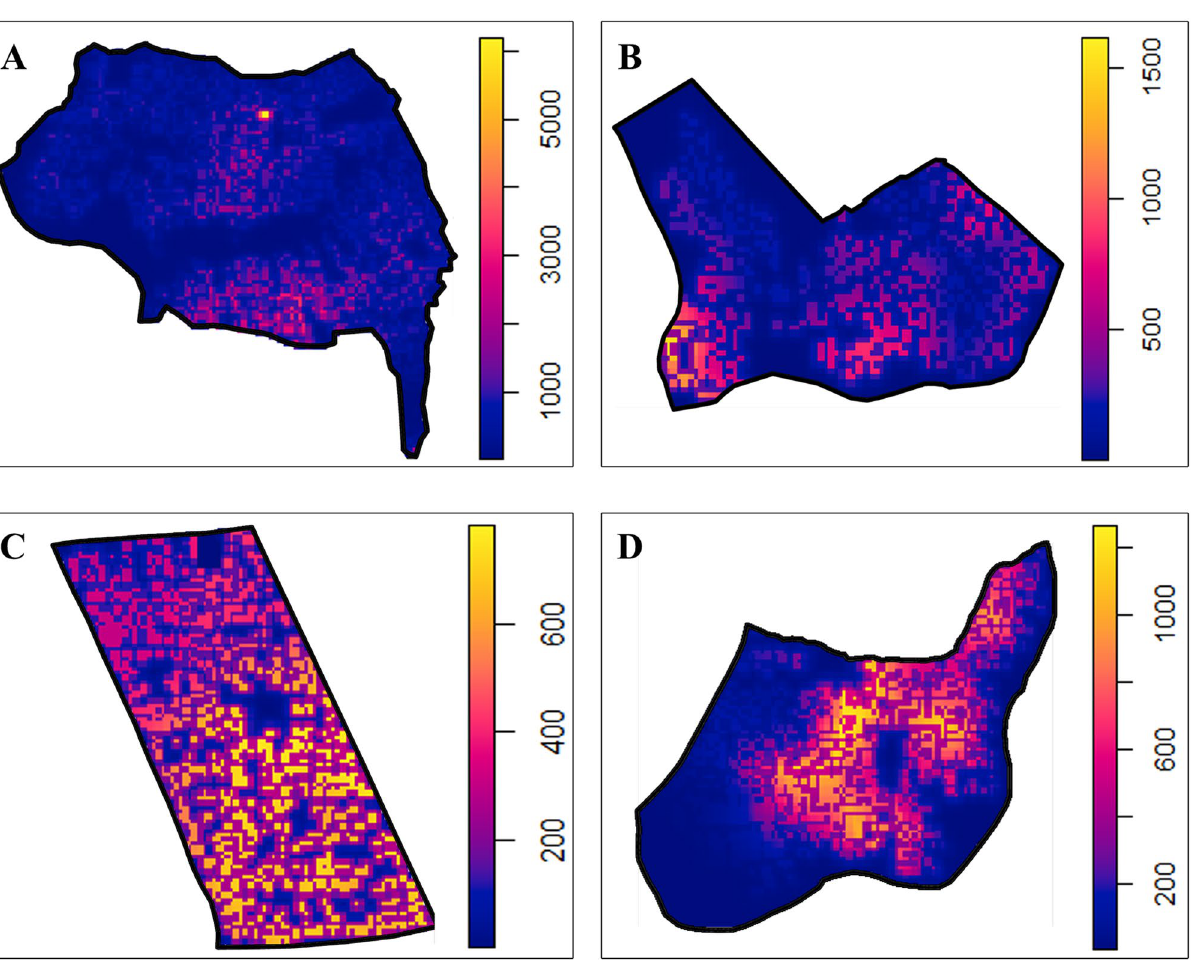
Figure 2. Predicted point pattern intensity for dengue incidences in the respective study areas. High risk localities were illustrated in the yellow colour while the low risk localities were illustrated in the blue. Variation of intensity levels are scaled adjacently to the intensity map of the study areas. ( A ) Eriyawetiya; ( B ) Akbar Town; ( C ) 3 rd Kurana; ( D )